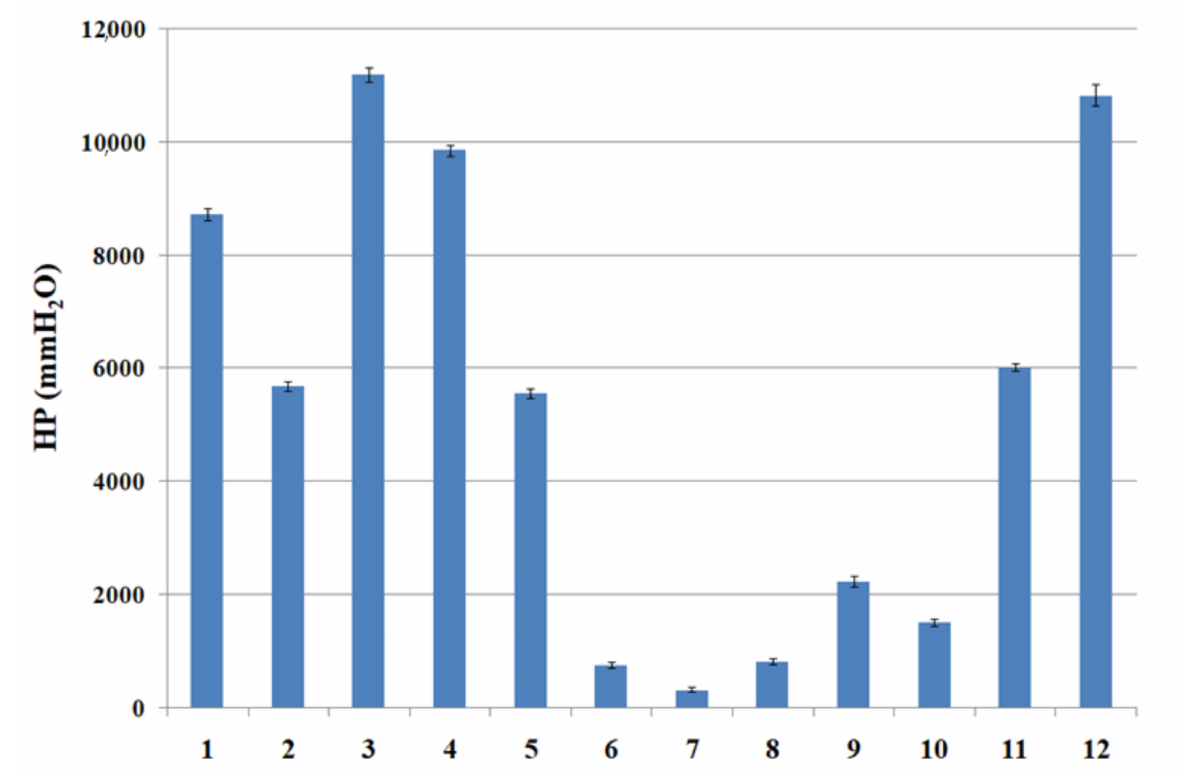
Figure 2. HP of twelve fabric